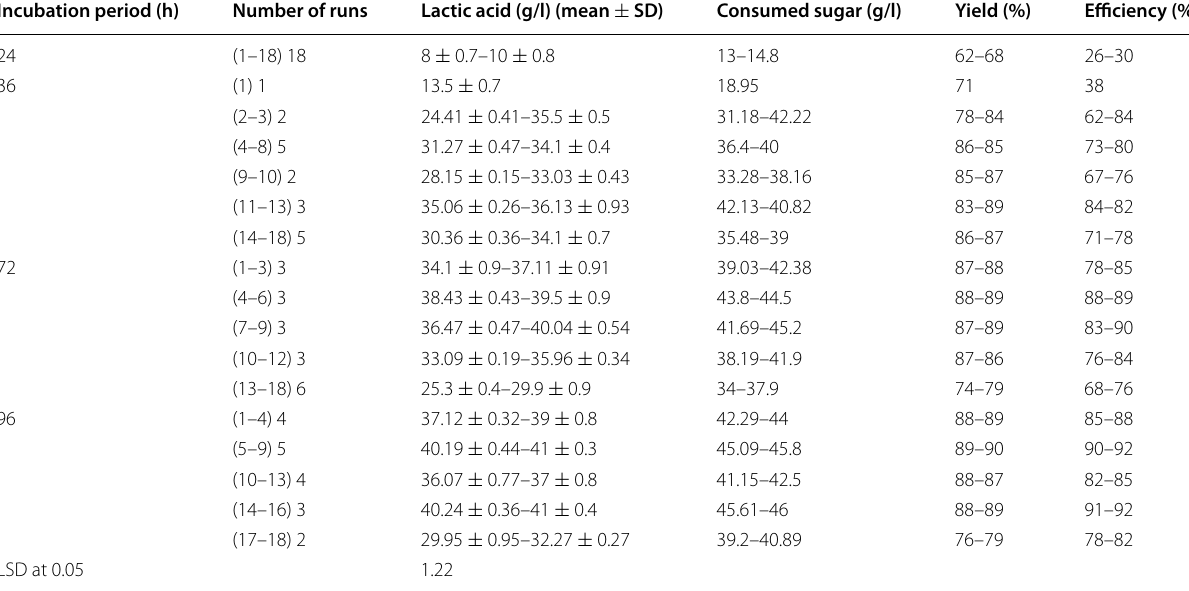
Substrate: salted cheese whey and whey permeate mixture (1:1) with CaCO 3 (0.5%), inoculum size (4%)